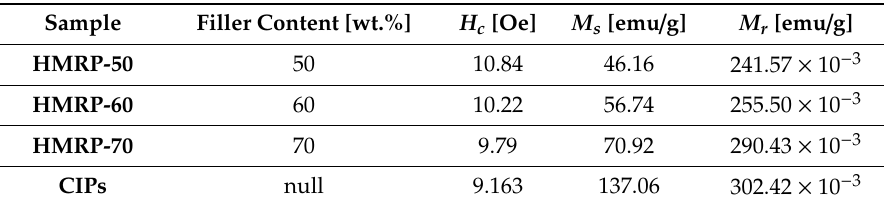
Table 1. Magnetic parameters from the magnetization